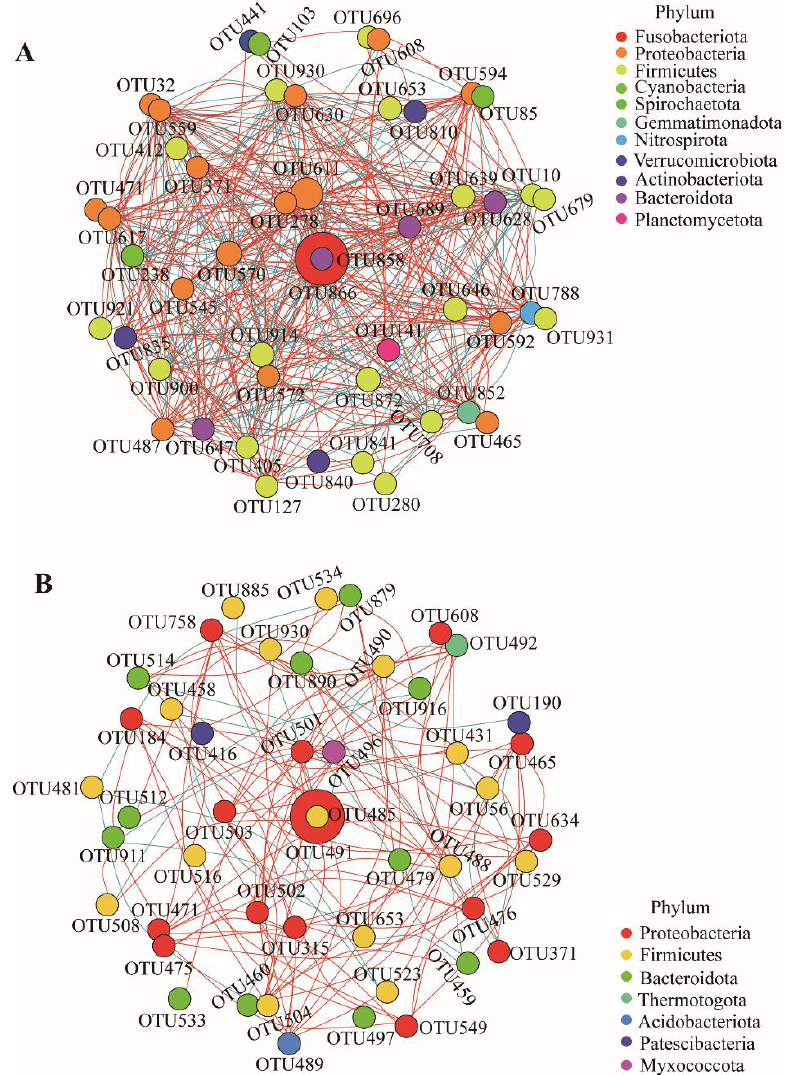
Figure 4. Networks of co-occurring bacterial OTUs of the healthy and diseased groups (Top 50% relative abundance). Only Spearman’s correlation coefficient (r > 0.4 or r < − 0.4) is shown. The nodes are colored according to phyla. Red edges represent positive correlations, and blue edges represent negative correlations. Node size is the relative abundance of each OTU, and edge thickness is proportional to the weight of each correlation. ( A ) healthy group, ( B ) diseased group.